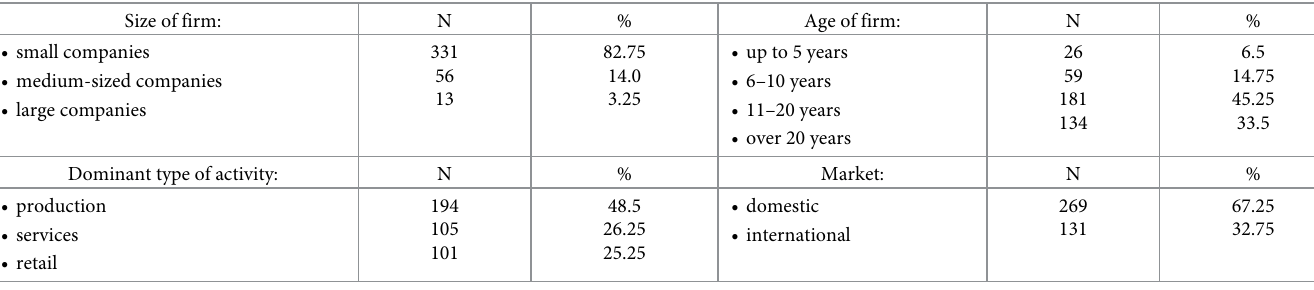
Table 1. Profile of responding